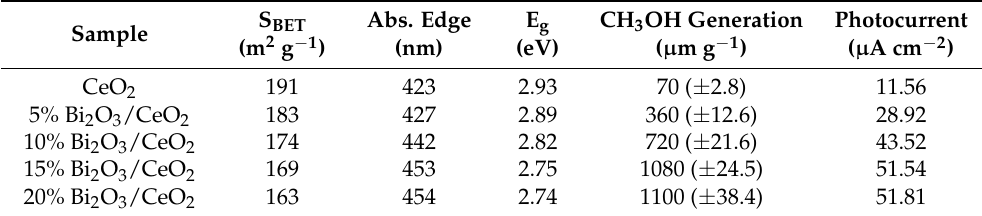
Figure 3. N 2 adsorption/desorption isotherms and corresponding pore size distribution (inset) for prepared CeO 2 compared to 15% Bi 2 O 3 /CeO 2 heterojunctions as indicated.